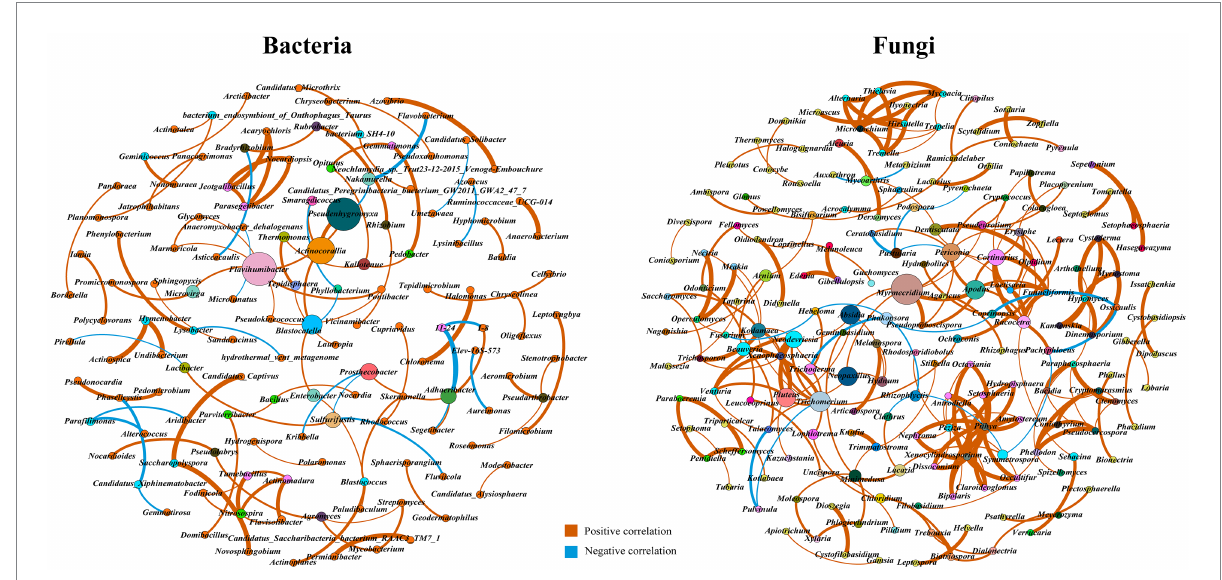
FIGURE 3 Co-occurrence networks of bacterial and fungal communities based on Spearman correlation.